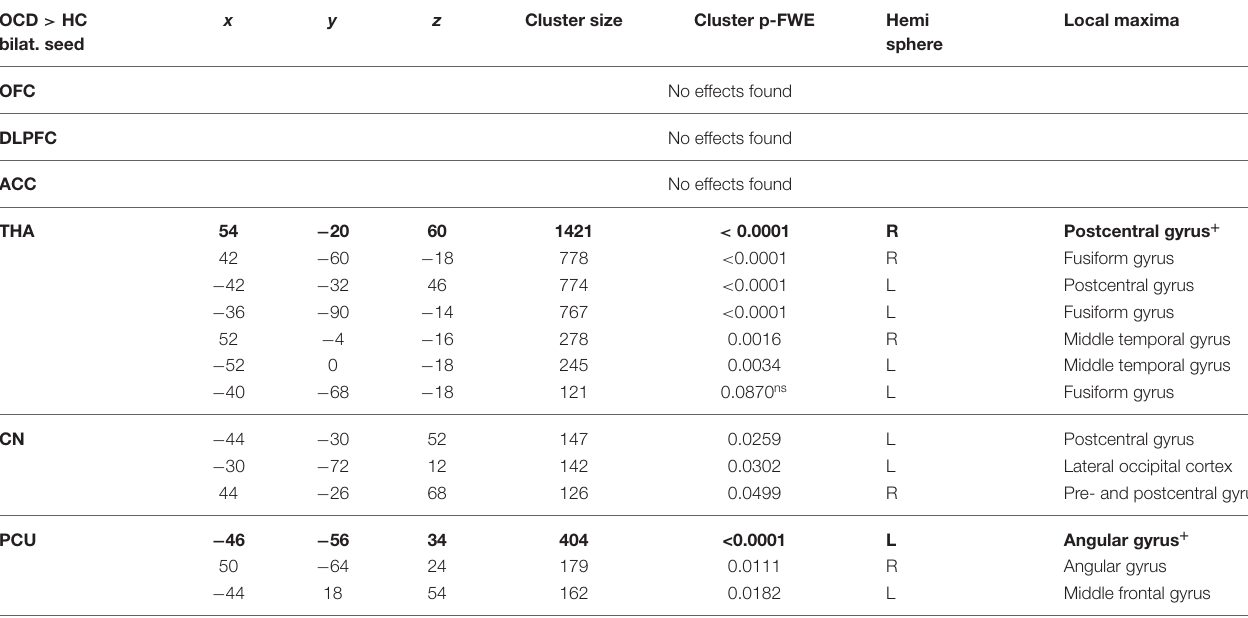
TABLE 3 | Increased connectivity in the OCD patients compared to HC in the selected